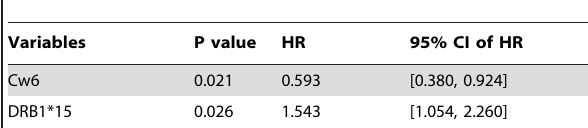
Table 3. Univariate relapse free survival (RFS)